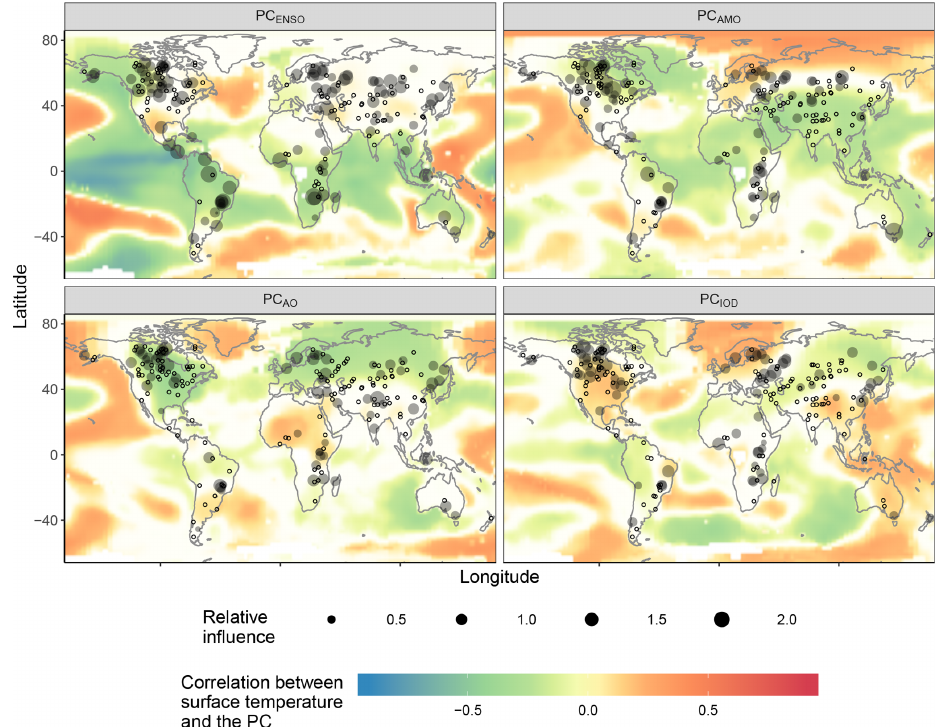
Figure 3. The relative influence of different axes of background climate variation (PCs) on water level variation. Empty dots represent lakes for which the PC was not selected in its “best model”. The opacity of each colored pixel in each map is related to the significance of the correlation between the PC and temperature at that pixel, with less significant correlations appearing white.